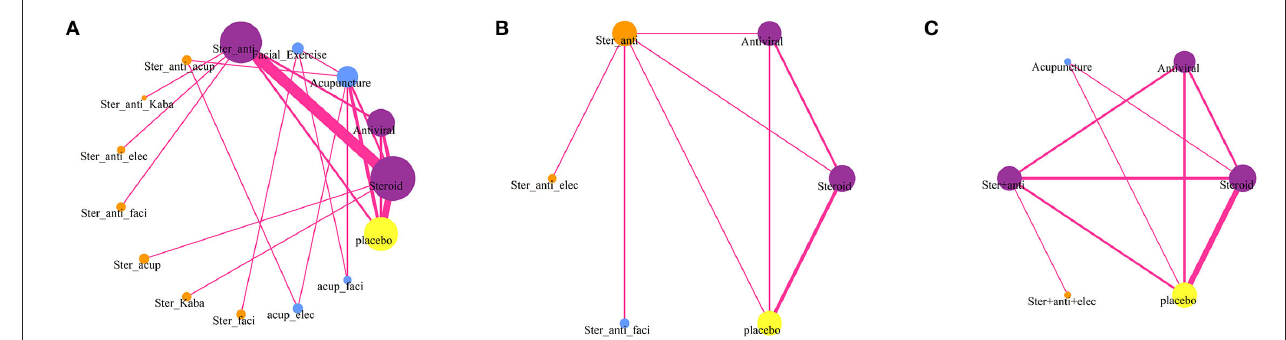
FIGURE 1 | Network diagrams of comparisons on different outcomes of treatments of patients with Bell’s palsy. (A) Comparisons on facial recovery in patients with Bell’s palsy. (B) Comparisons on sequelae in patients with Bell’s palsy. (C) Comparisons on adverse events in patients with Bell’s palsy. The node size is proportional to the total number of patients receiving treatment. Each line represents a type of head-to-head comparison. The width of lines is proportional to the number of trials comparing the connected treatments (Ster, Steroid; Anti, antiviral; Kaba, Kabat treatment; Elec, Electrical stimulation; Acup, Acupuncture; Faci, Facial exercise).